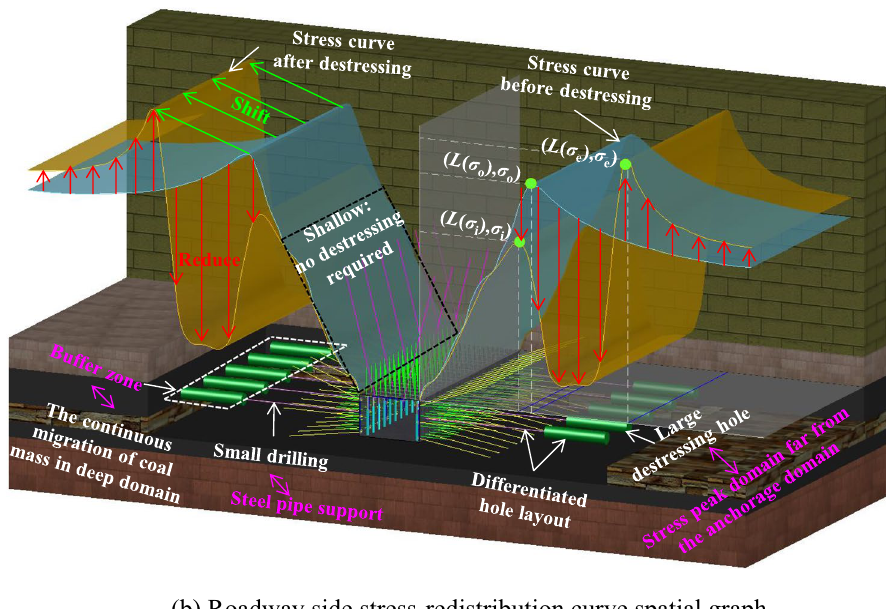
Figure 8. Roadway side tress redistribution